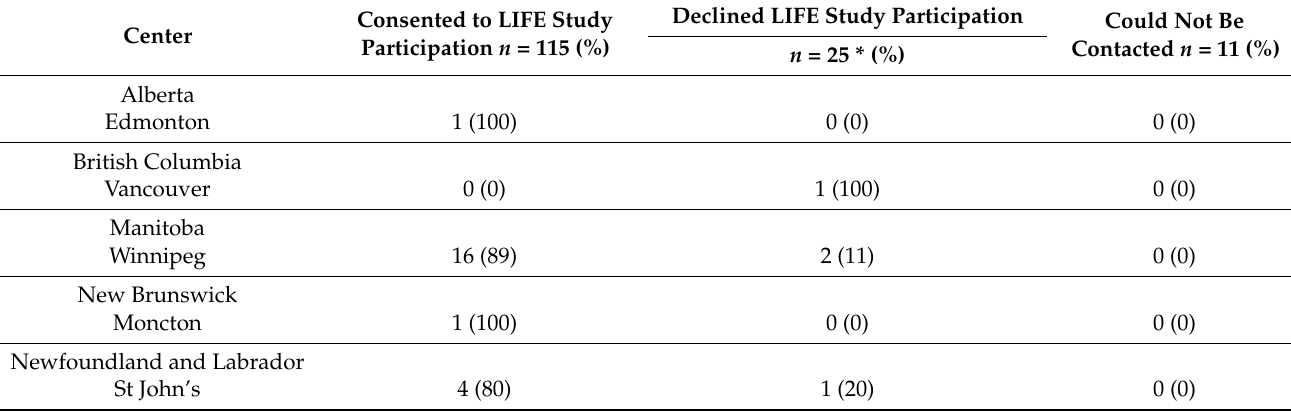
Table 1. LIFE study patient acceptance rates by